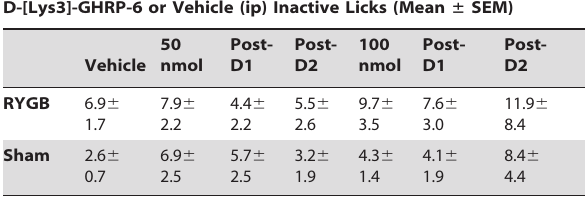
Table 1. Inactive licks were not altered significantly by ghrelin